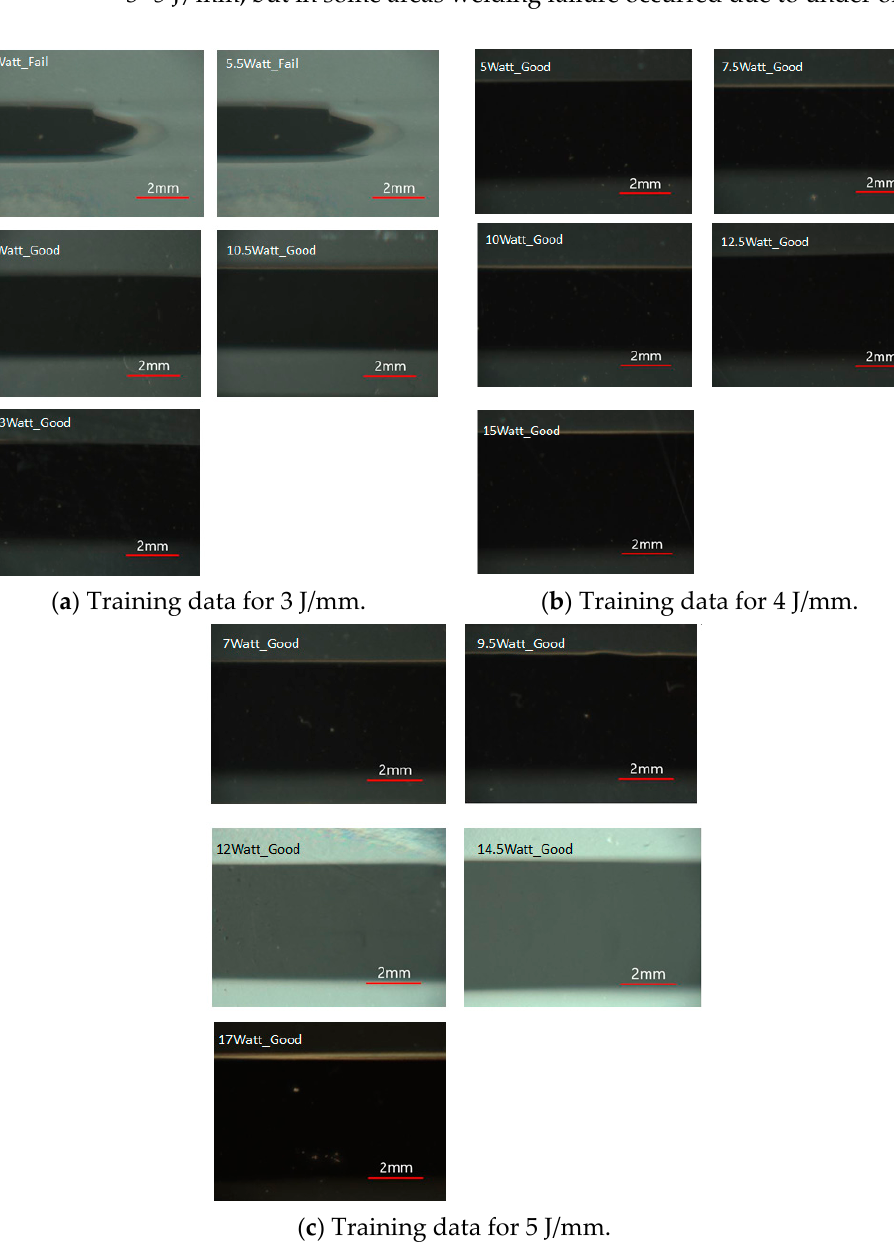
Figure 5. Training data sets for different energy inputs.